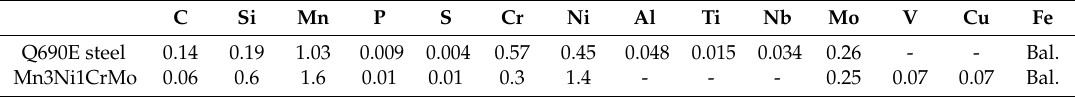
Table 2. Chemical compositions of the base metal and welding filler wire (wt.